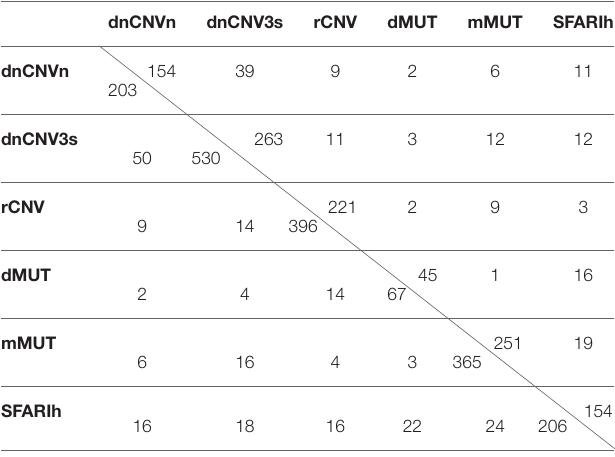
TABLE 1 | Overlap between lists of genes harboring variations associated with